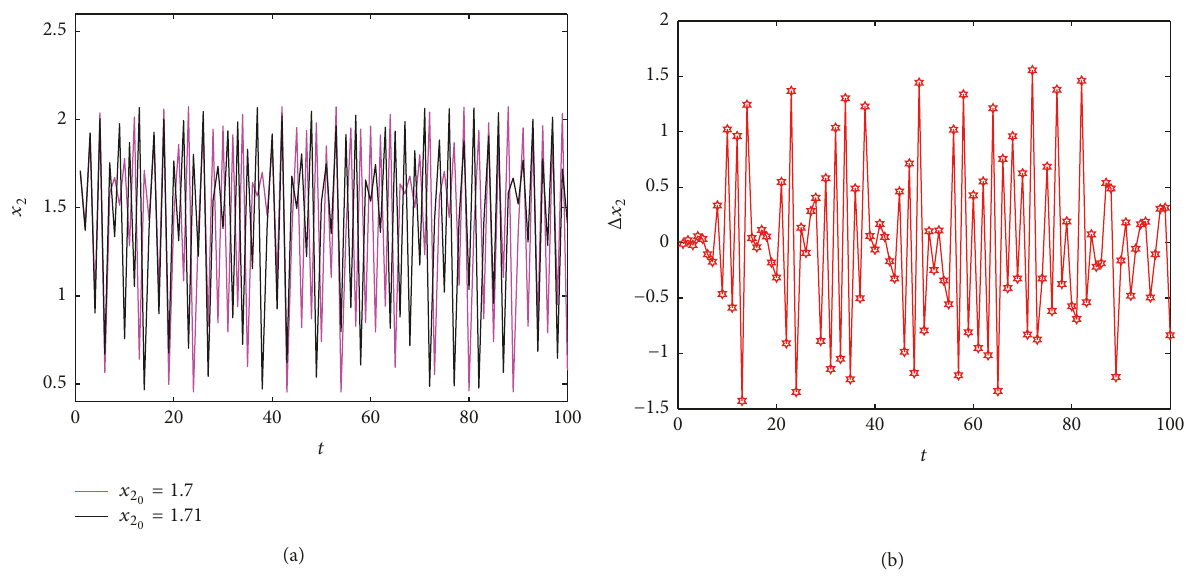
Figure 14: The two orbits and difference of 𝑥 2 coordinates for initial points (1.4, 1.7) and (1.4, 1.71) and (𝛼 1 = 0.42, 𝛼 2 = 1.34) .